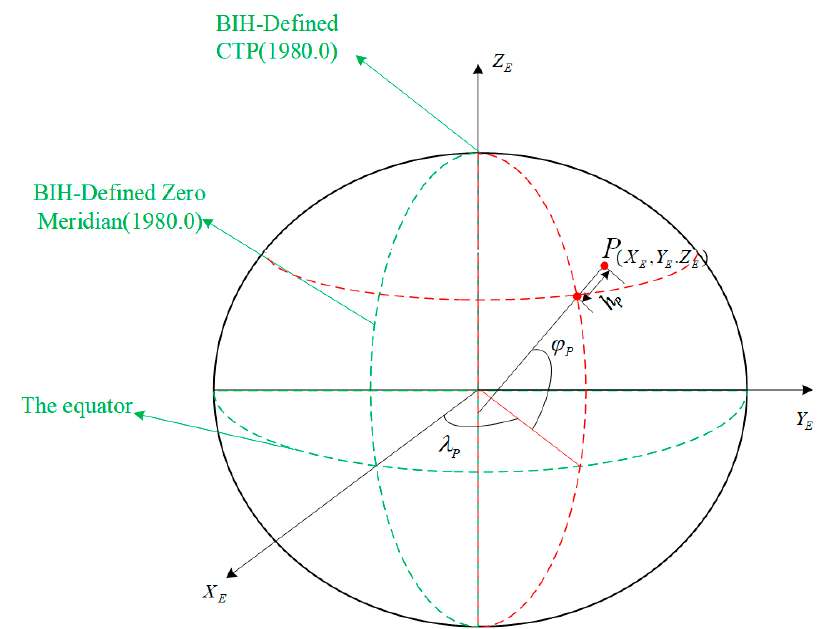
Figure 1. ECEF coordinate system and description of longitude and latitude. The mathematical model of the ellipsoid is defined by the following